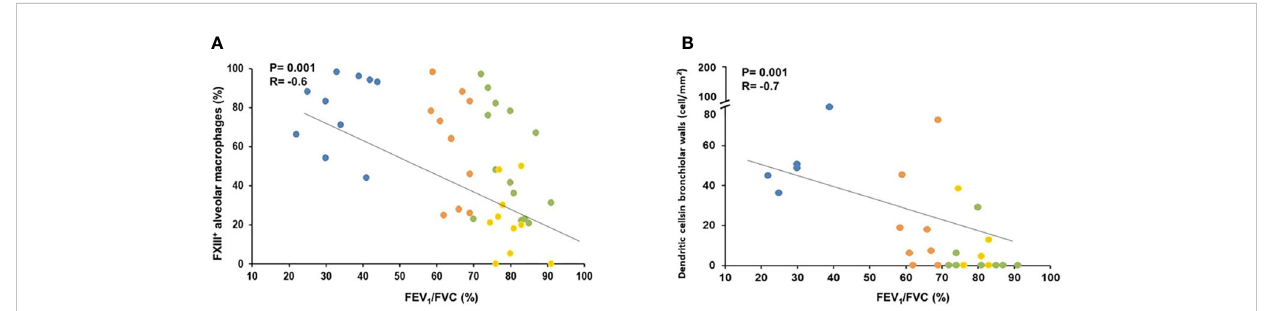
FIGURE 6 Correlation of lung function (FEV 1 /FVC%) with % of FXIII+ alveolar macrophages and number of dendritic cells in bronchiolar wall. (A) FEV 1 /FVC (%) correlated negatively with the percentage of FXIIIA+ alveolar macrophages. Spearman rank correlation (r= − 0.6 and p=0.001). (B) FEV 1 /FVC (%) correlated negatively with the numbers of dendritic cells in bronchiolar. Spearman rank correlation (r= − 0.7 and p=0.001). Smokers with severe COPD (blue circles), mild/moderate COPD (orange circles), smokers without COPD (green circles) and non-smokers (yellow